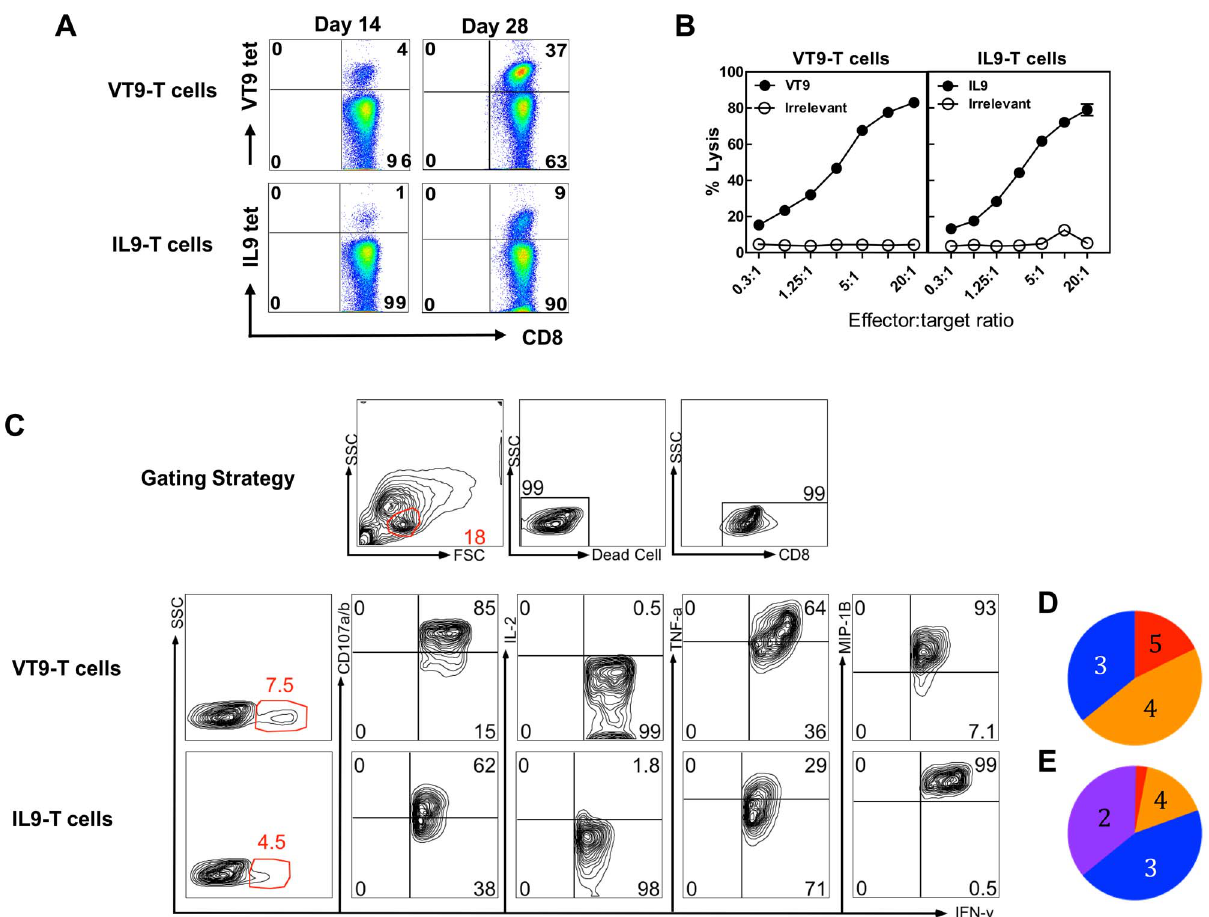
Figure 2. Characteristics of VT9- and IL9-specific CD8 + T cells. Panel A shows progressive increase of VT9- and IL9-specific CD8 + T cells with culture. Panel B shows these epitope-specific CD8 + T cells to be cytotoxic as judged by the chromium release assay over a range of E:T ratios (0.3 to 20:1) using T2 target cells pulsed with 10 m g/ml peptides. Panel C shows a representative gating strategy used to isolate viable CD8 + small lymphocytes in the cultures and the dot plots of IL9- and VT9-specific T cells defining the IFN c + subset were polyfunctional as shown by polychromatic flow cytometry (degranulation by surface expression of CD107a/b) and secretion of IL-2, TNF a , and MIP-1 b ). Panel D and E are pie charts summarizing the four possible functional outcomes according to the number of additional functions for IFN c -producing VT9- and IL9-specific T cells, respectively. Pie slices represent the proportion of responding CD8 + T cells that upregulated 5 (red), 4 (orange), 3 (blue), and 2 (purple) function(s).